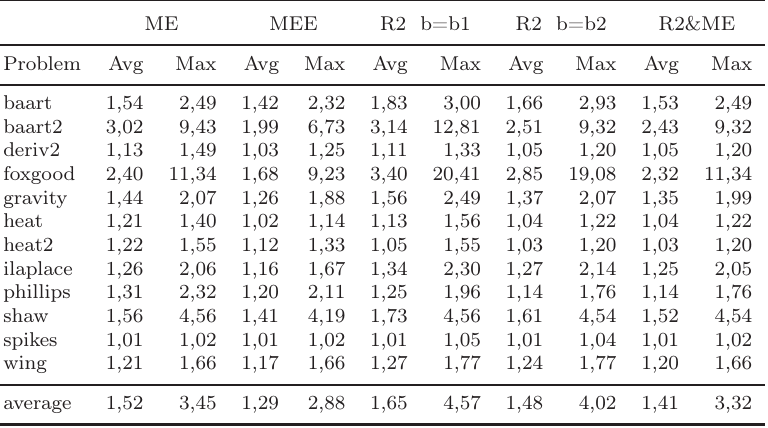
Table 1. Error ratios in case of k f − f δ k = δ .